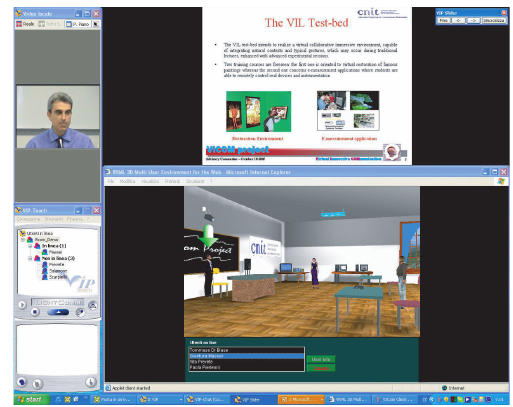
Figure 4: GUI in the lecture session.